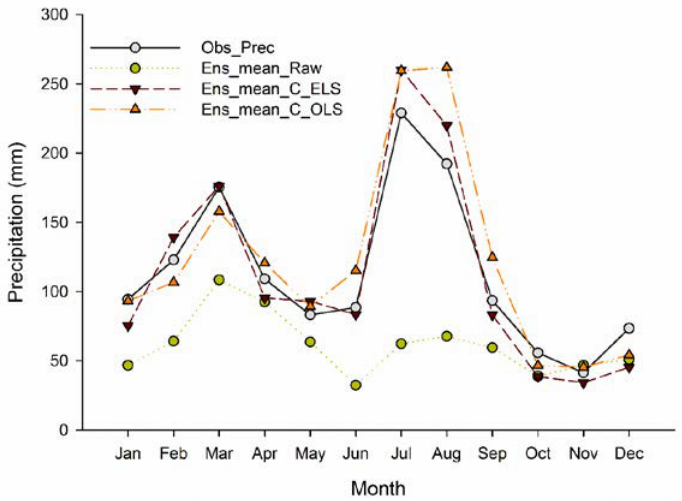
Figure 7. Observed precipitation against ensemble mean of five GCMs taken from raw GCM data, corrected with PELS, and corrected with OLS.